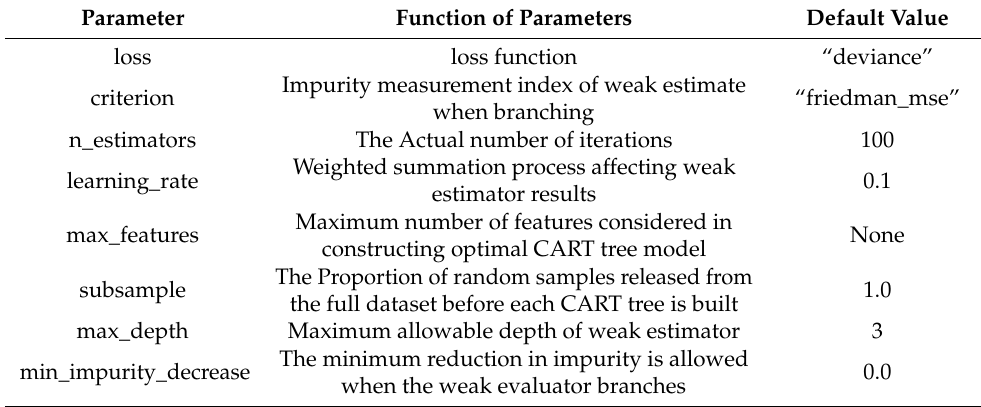
Table 2. GBDT hyperparameters selected and default values in